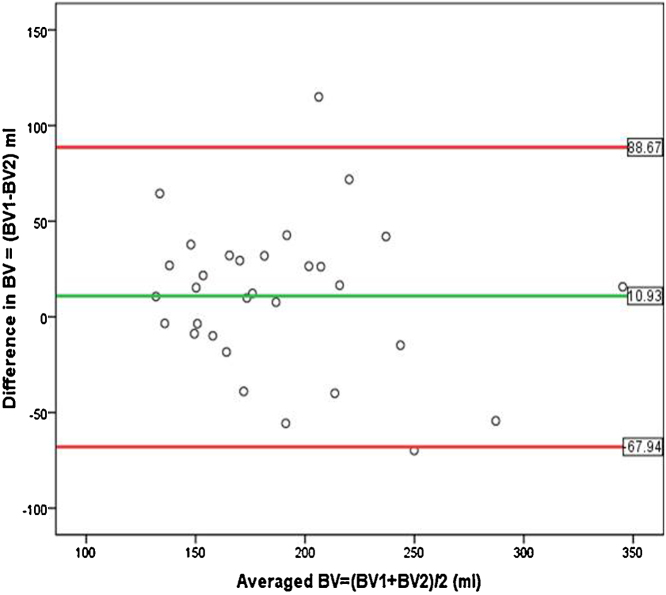
Bland and Altman plot: Repeatability of 51Cr (III) method (n = 31).